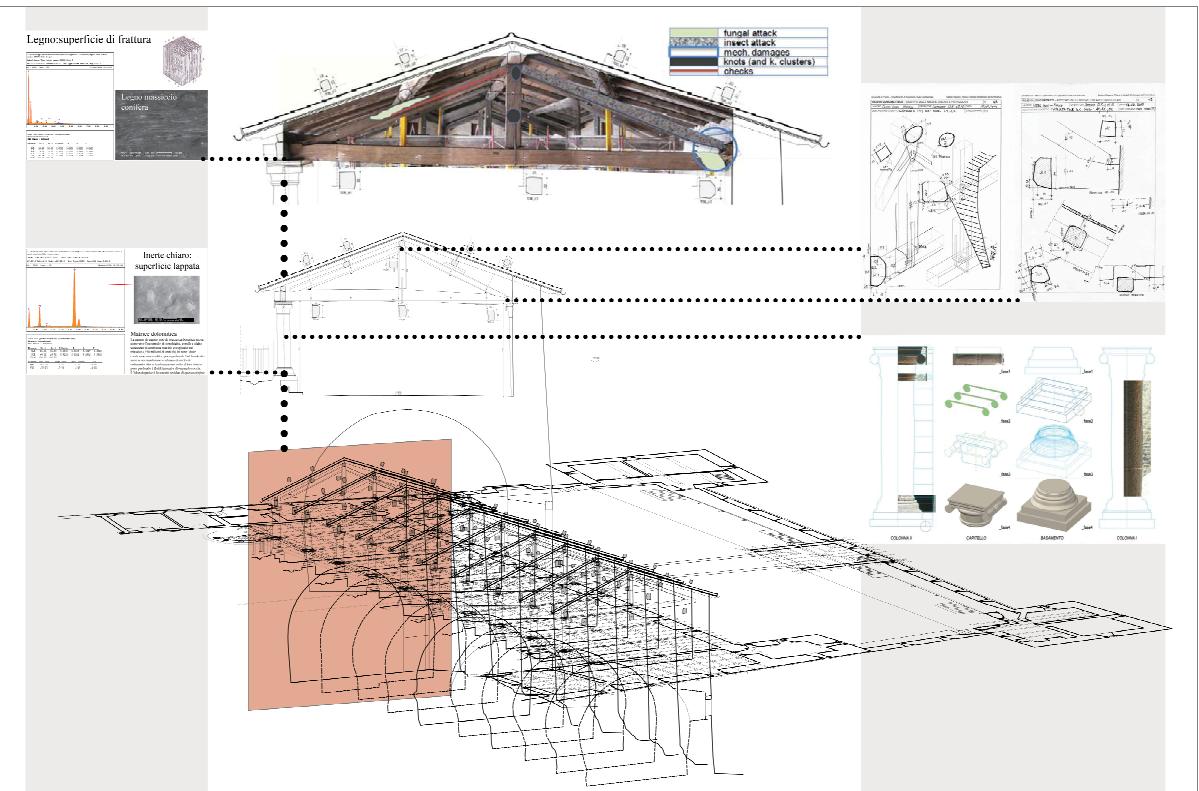
Figure 4. Layout of the data integrated management in the 3D digital